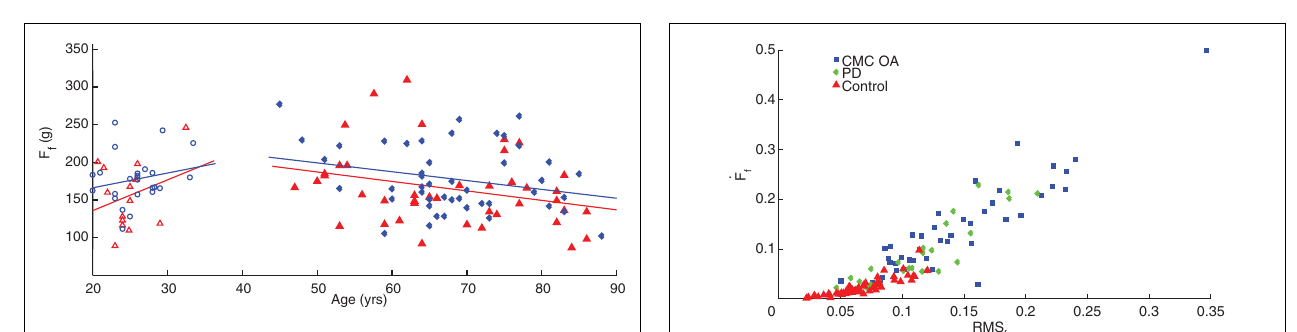
FIGURE 3 | Linear regression of finger compression force with respect to age .Younger adults (empty symbols) tended to show an increase in compression force while older adults (filled symbols) showed a decrease. Male participants (blue circles) tended to have greater values than females (red triangles) as indicated by the position of the fit lines. See Table 3 .